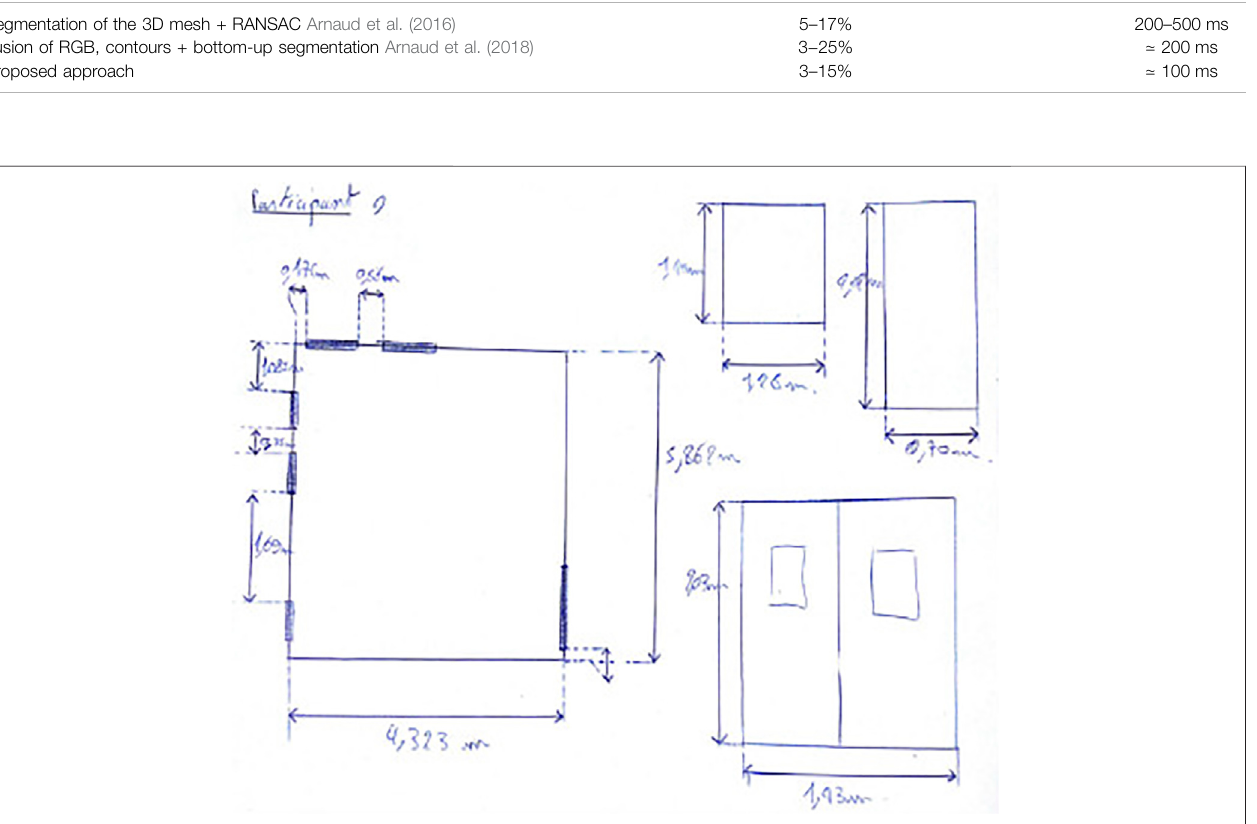
FIGURE 12 | Example of sketch drawn by an user during the usability experiment.